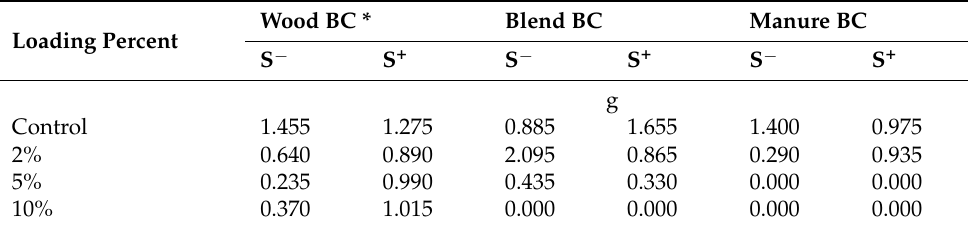
Table 2. Trifolium incarnatum herbage dry weight medians according to saturation and loading